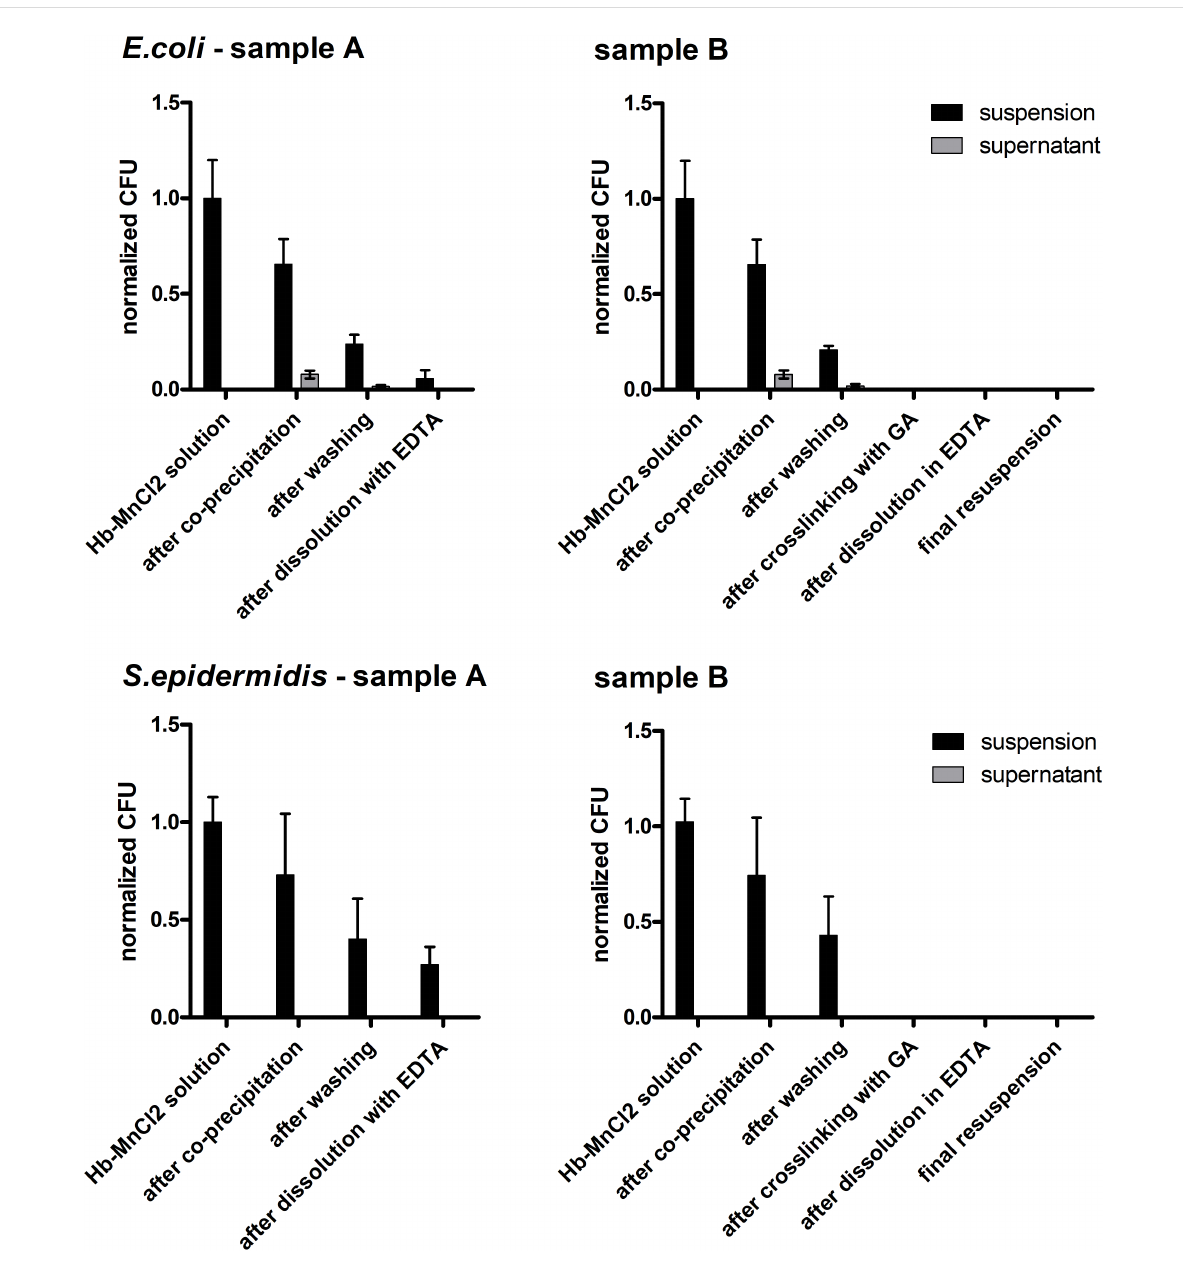
Figure 7: Particle preparation with E. coli and S. epidermidis . The solution containing hemoglobin and MnCl 2 was spiked with E. coli (upper row) or S. epidermidis (lower row) and coprecipitated with Na 2 CO 3 . The resulting particles were washed with NaCl and either the salt template was directly dissolved (sample A) or the particles were cross-linked with glutaraldehyde and then dissolved with EDTA (sample B). At each given production step, the number of colony-forming units was determined. Error bars are SD, n = 8, except for the “Hb–MnCl 2 solution” group ( n = 4).